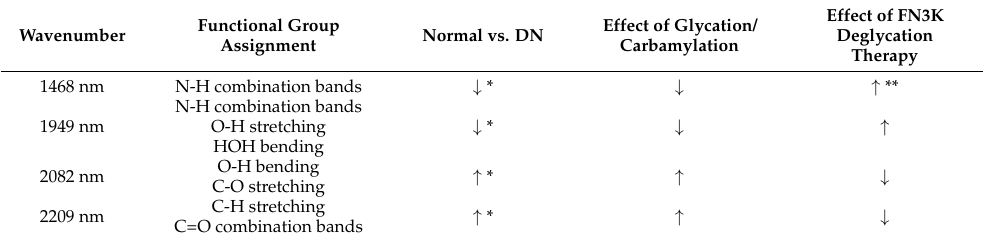
Table 3. Overview of the effect of glycation/carbamylation and fructosamine-3-kinase (FN3K) deglycation on peak intensities at 1468, 1949, 2082, 2209, and 2279 nm [74]. DN: diabetic nephropathy; FN3K: fructosamine-3-kinase, ↓ : decrease, ↑ : increase. * p < 0.05; ** barely restored after FN3K deglycation